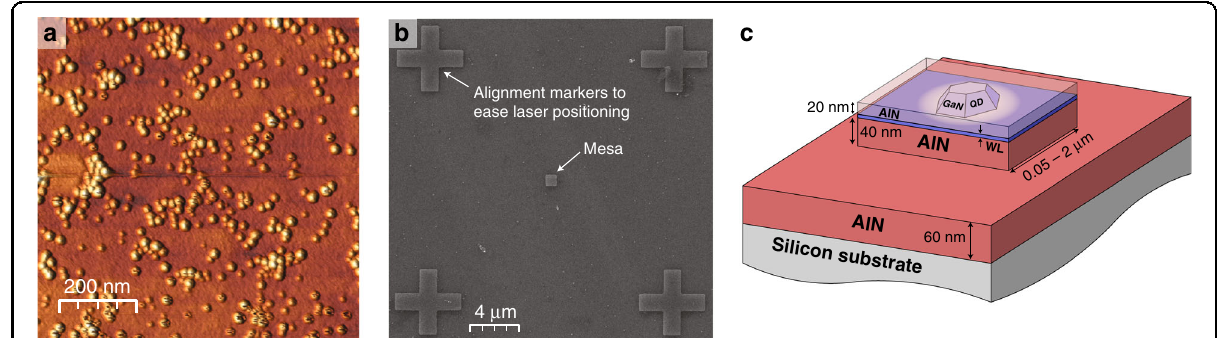
Fig. 13 Description of the sample structure. a 1 × 1 µm 2 AFM image taken in height mode of the top plane of GaN QDs displaying a broad distribution of dot sizes. b 26 × 26 µm 2 secondary electron image of the SA QD sample after evaporation of the top QD plane and etching into mesa structures. The displayed mesa is 1 µm wide. c Sketch of the mesa structure. In practice, several QDs can be present on each mesa depending upon their